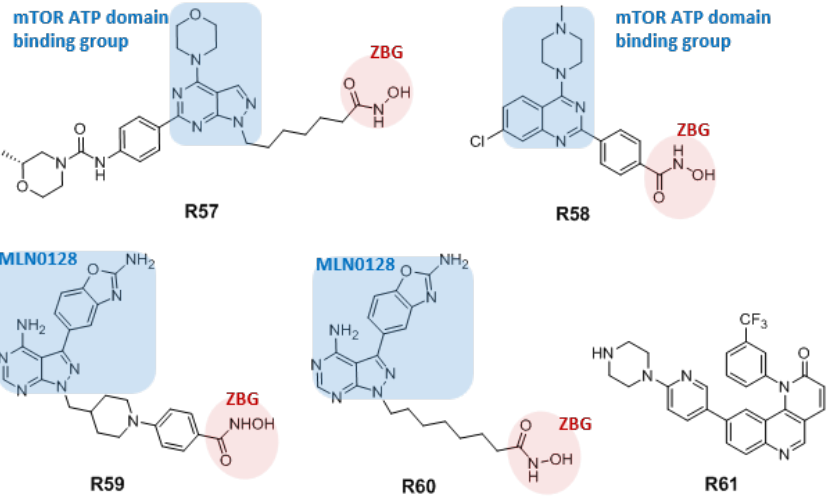
Figure 10. Structures of dual mTOR/HDAC inhibitors R57 - R60 and ATR/mTOR dual kinase inhibitor R61 .